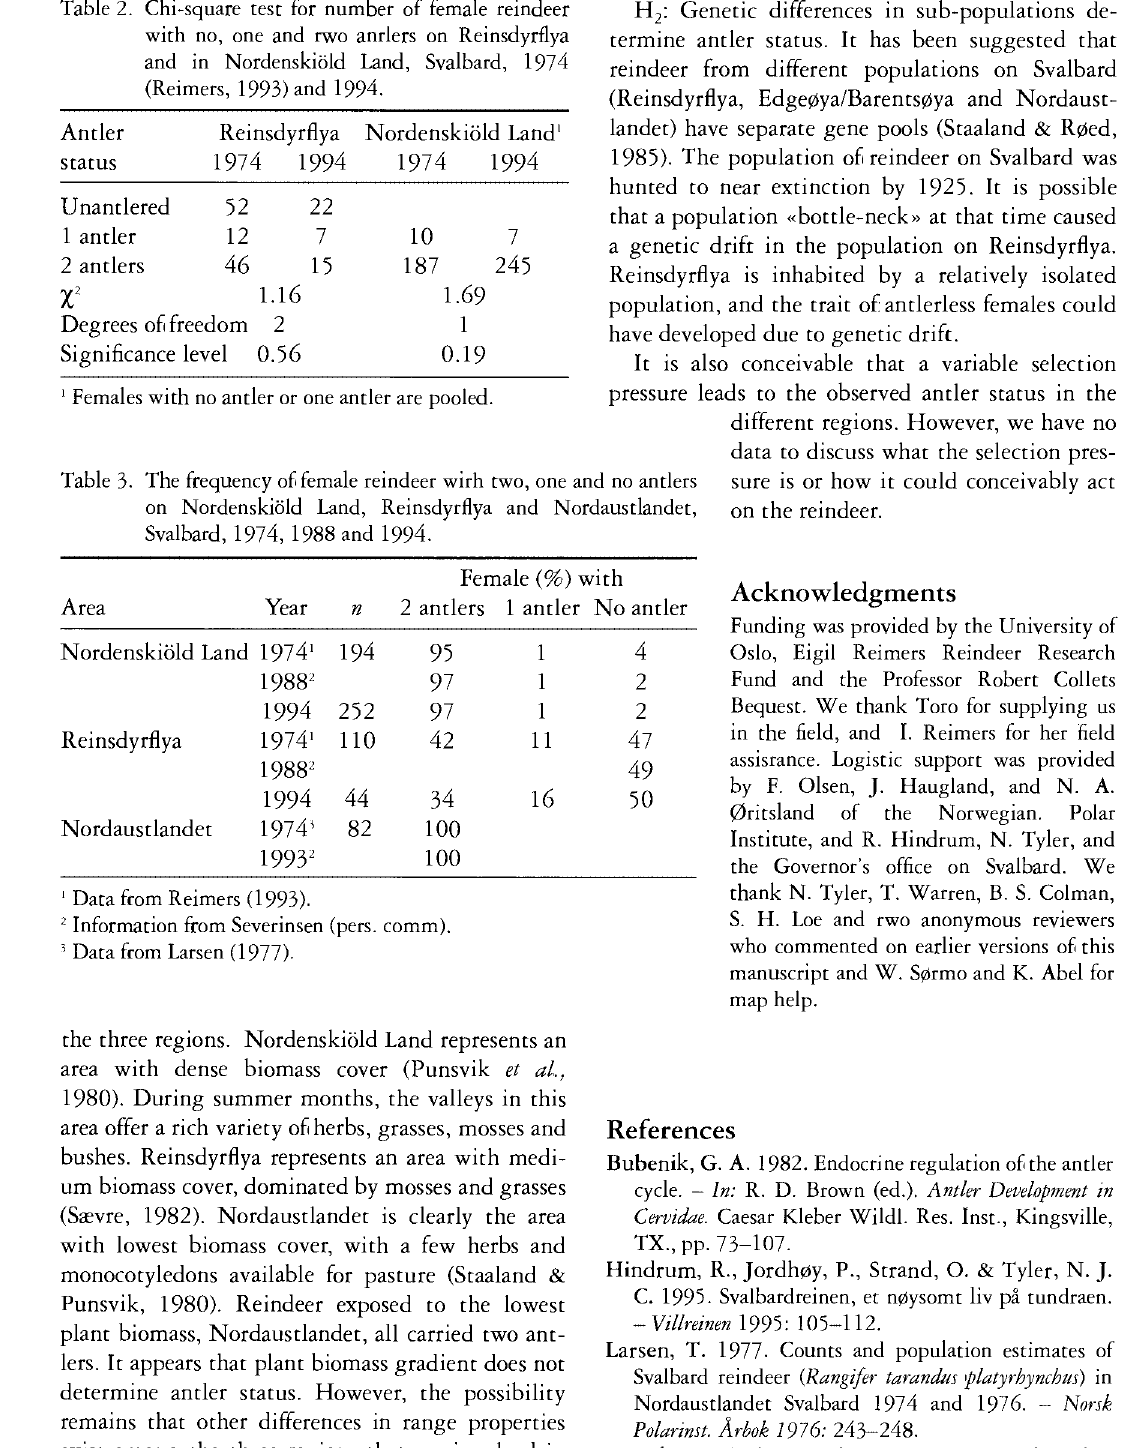
Table 3. The frequency of female reindeer wirh two, one and no antlers on Nordenskiold Land, Reinsdyrflya and